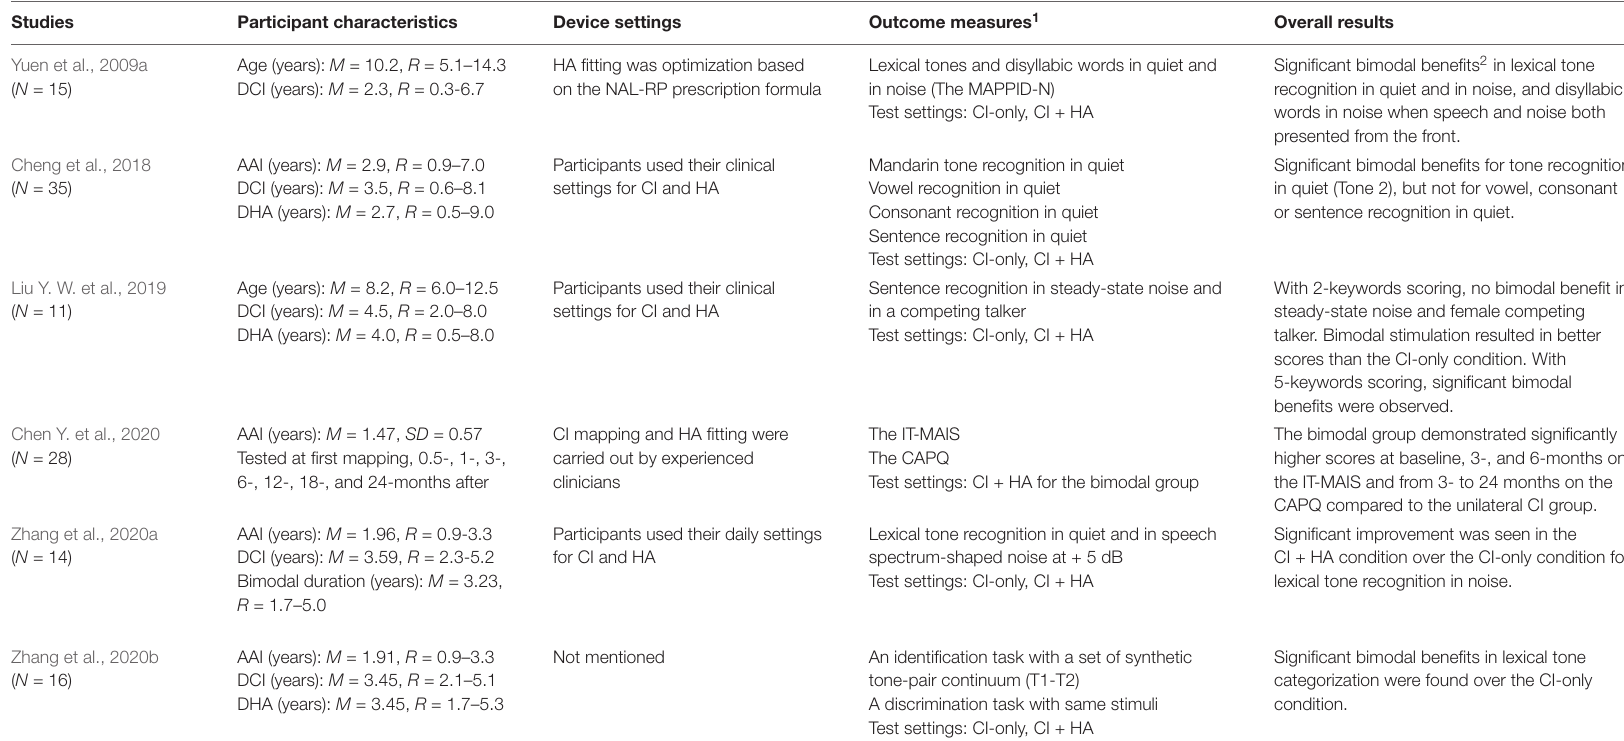
TABLE 5 | Speech perception of children with bimodal